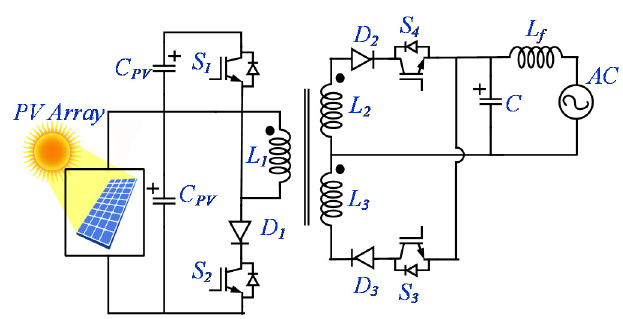
Figure 21. Single stage fly-back inverter with decoupling circuit .